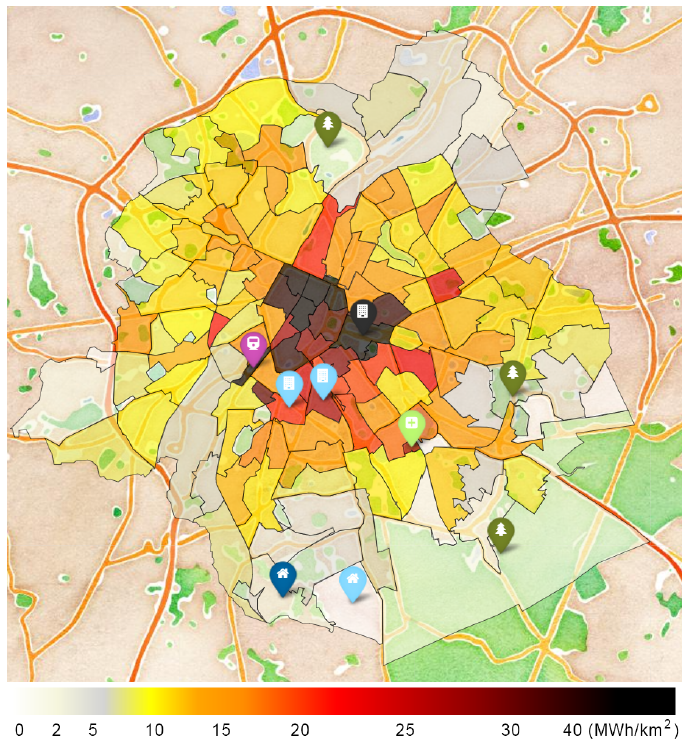
Figure 6. Total Public EV Charging demand normalized by the neighborhood’s areas (both regular and irregular trips aggregated). The various markers were added to attract the reader’s attention. Addition information about them is given in the core text. Units: MWh/km 2